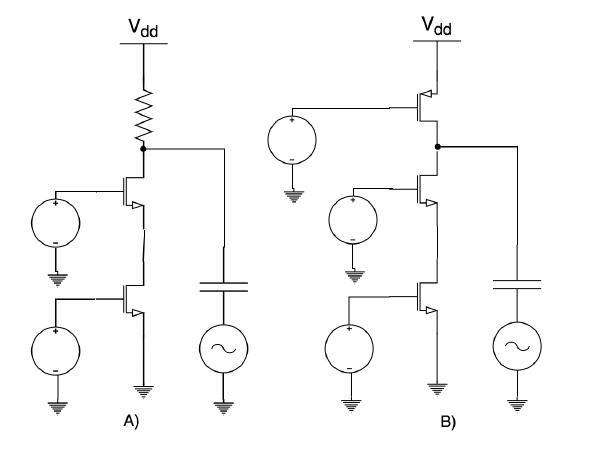
Figure 11. Schematics of the cascode stage, with passive ( A ) and active ( B ) load